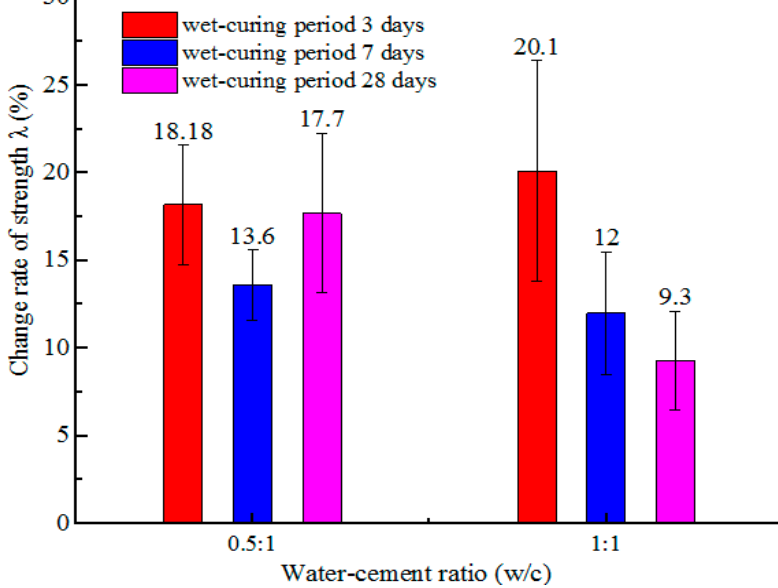
Figure 13. The values of λ of hardened cement grouts.